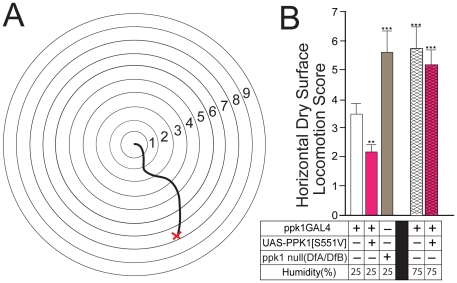
Correlation of genotype-specific effects of transgenic mdIV nociceptor manipulation in a horizontal dry surface locomotion assay.(A) Schematic representation of the horizontal dry surface locomotion assay(see Materials and Methods). (B) Horizontal locomotion behavior parallels genotypic differences in PHI. Wandering stage larvae of the indicated genotypes were assayed in an alternative protocol for larval locomotion on a dry horizontal glass surface under constant humidity. Higher scores represent increased distance of movement away from a moist filter over a dry glass surface(see Materials and Methods). Paralleling results from determination of PHI, ppk1-GAL4/UAS-PPK1[S551V] larvae expressing a constitutively active PPK1 isoform preferred to avoid extensive locomotion over the dry surface. The wild-type control ppk1-GAL4/+ larvae moved an intermediate distance and ppk1 null mutant larvae(w1118; DfA/DfB) moved a significantly increased distance over the dry glass surface before becoming stranded. When assayed under the same conditions except at high humidity levels(75%), both ppk1-GAL4/UAS-PPK1[S551V] and ppk1-GAL4/+ larvae displayed significantly increased locomotion over the dry glass surface. Error bars represent SEM with n>15 for all values. **P<.01, ***P<.0001, one-way ANOVA with Tukey posttest.